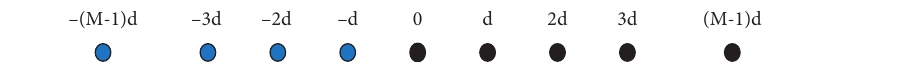
Figure 3: The structure of the symmetric uniform array, where the black array elements are real elements and the blue array elements are the corresponding virtual array elements.